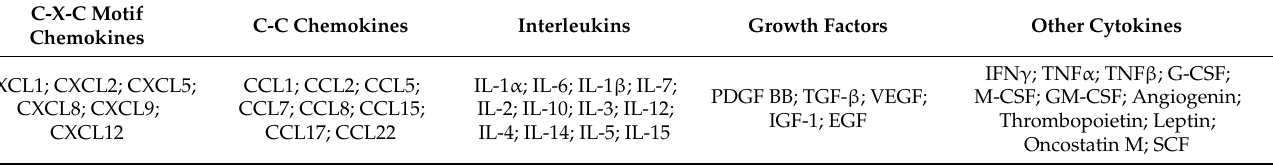
Table 2. Cytokines detected by the Human Cytokine Antibody Array